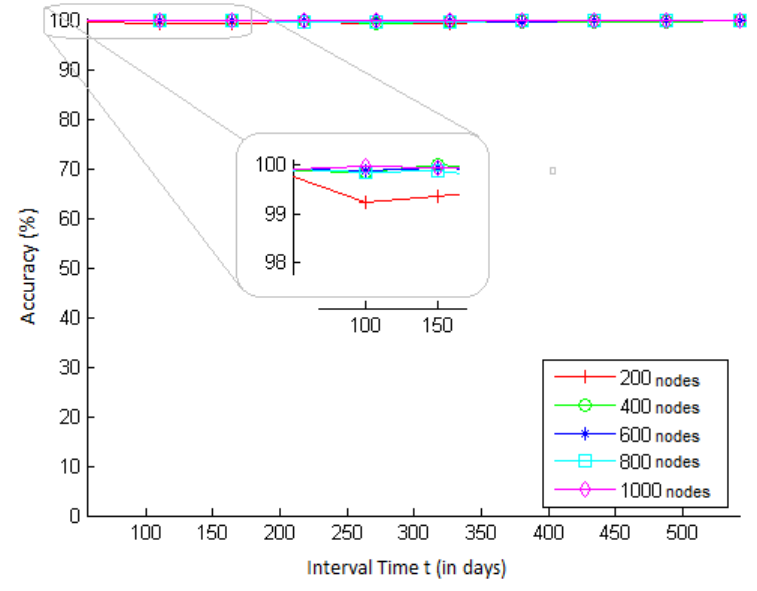
Figure 3. Accuracy of the key strength probability ( P sizes, for a test rate f = 394 , 875 , 793 , 722 keys/s, and s = 64